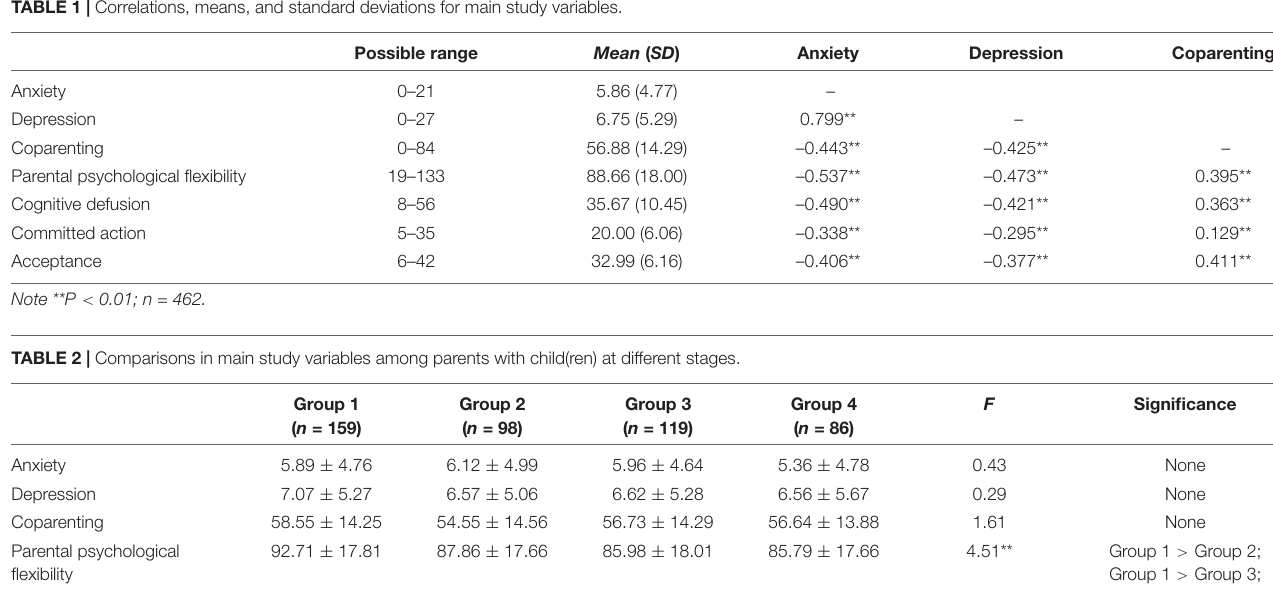
TABLE 1 | Correlations, means, and standard deviations for main study variables.